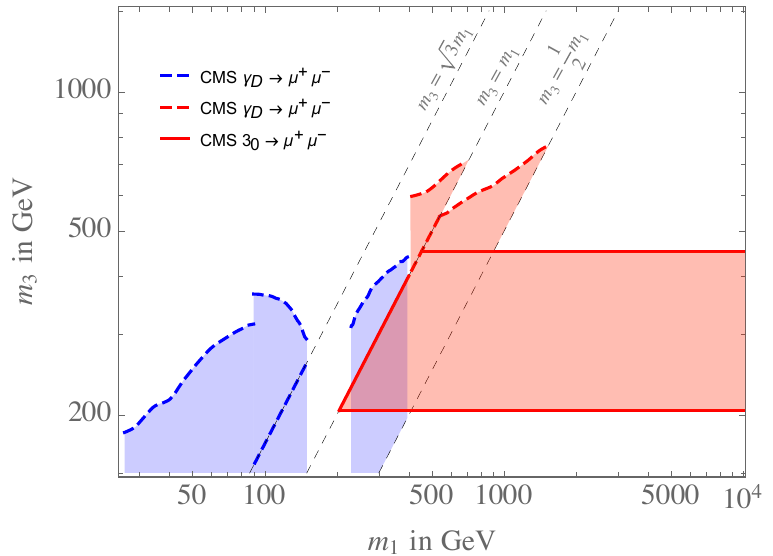
Figure 6 . Bounds from the Z 0 searches of refs. [81, 83] for m 1 = 2 m γ at N DC = 4 ). The plane is divided into different kinematic regions (see table 4) by the gray thin dashed lines, inside which each constraint is valid. While exclusions denoted by continuous lines correspond to the decays of the 3 0 and are valid for arbitrary values of ε , dashed curves refer to γ D decays and only apply for ε & 10 − 7 , i.e. when dark photons decay